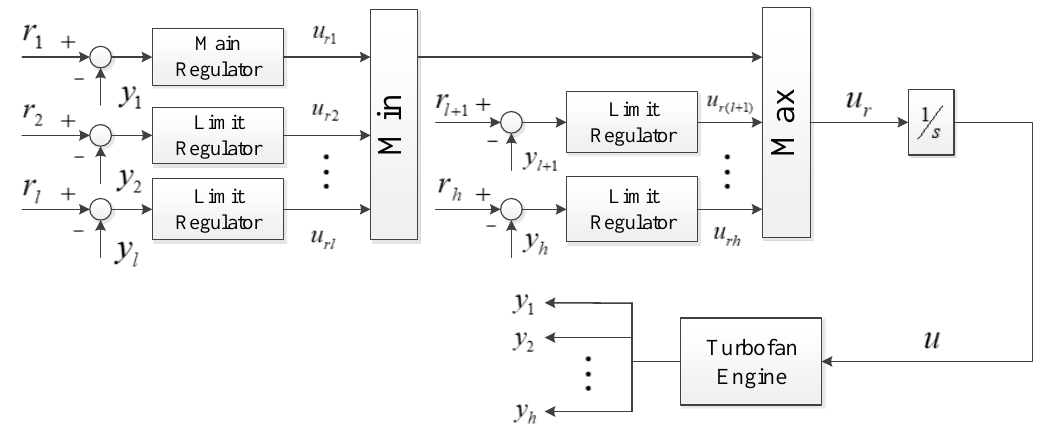
Figure 1. Structure of the traditional Min – Max architectures.